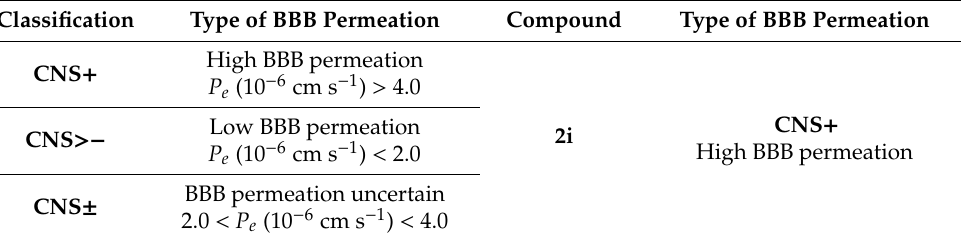
Table 3. Type of blood–brain barrier (BBB) penetration of compound 2i .